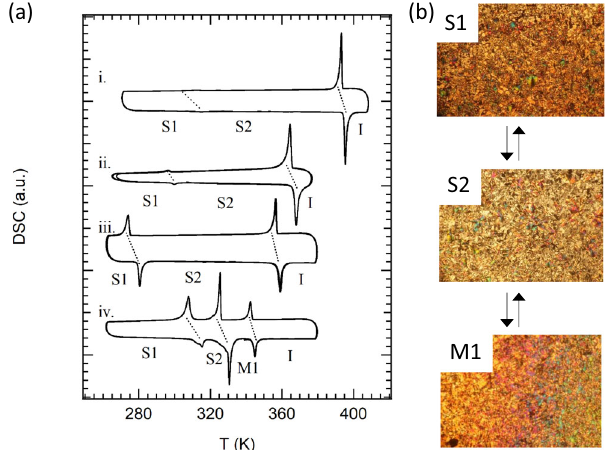
Fig. 4 Phase-transition behavior of C n SS derivatives ( n = 6, 8, 10, or 16). a DSC curves of (i) C6SS , (ii) C8SS , (iii) C10SS , and (iv) C16SS , where transformations between the S1, S2, and M1 phases were reversible in the T -cycle. b POM images of C16SS at S1 ( T = 300 K), S2 ( T = 320 K), and M1 ( T = 330